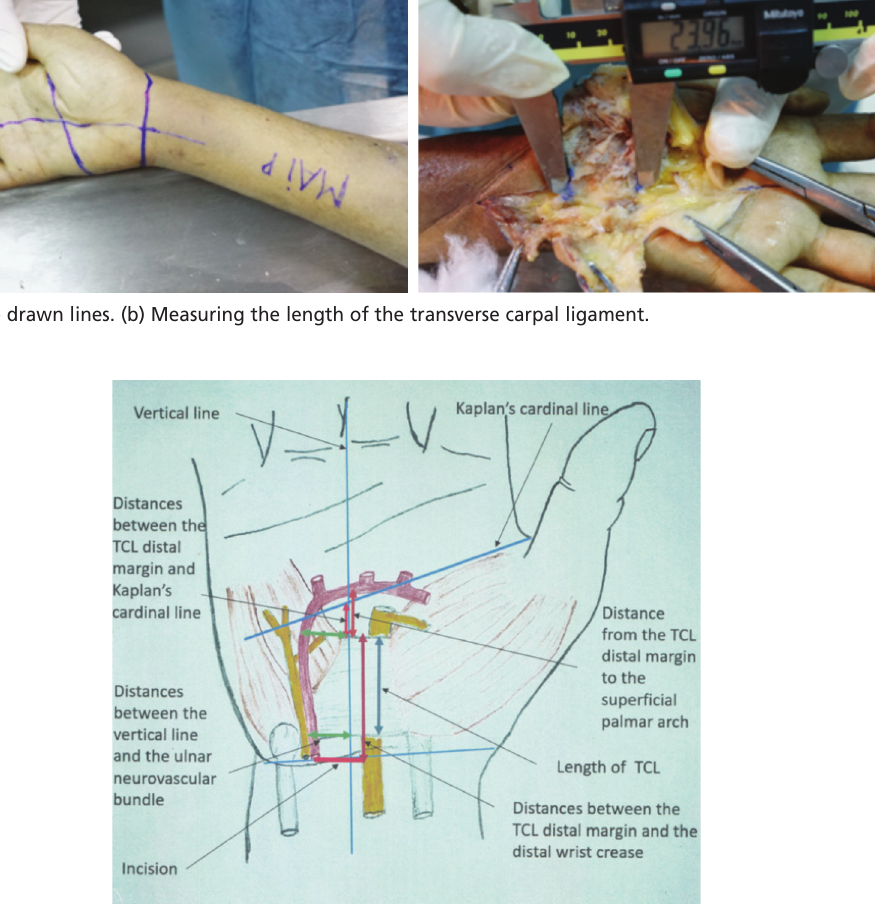
Orthopaedic measurements in single portal endoscopic carpal tunnel Fig. 2: